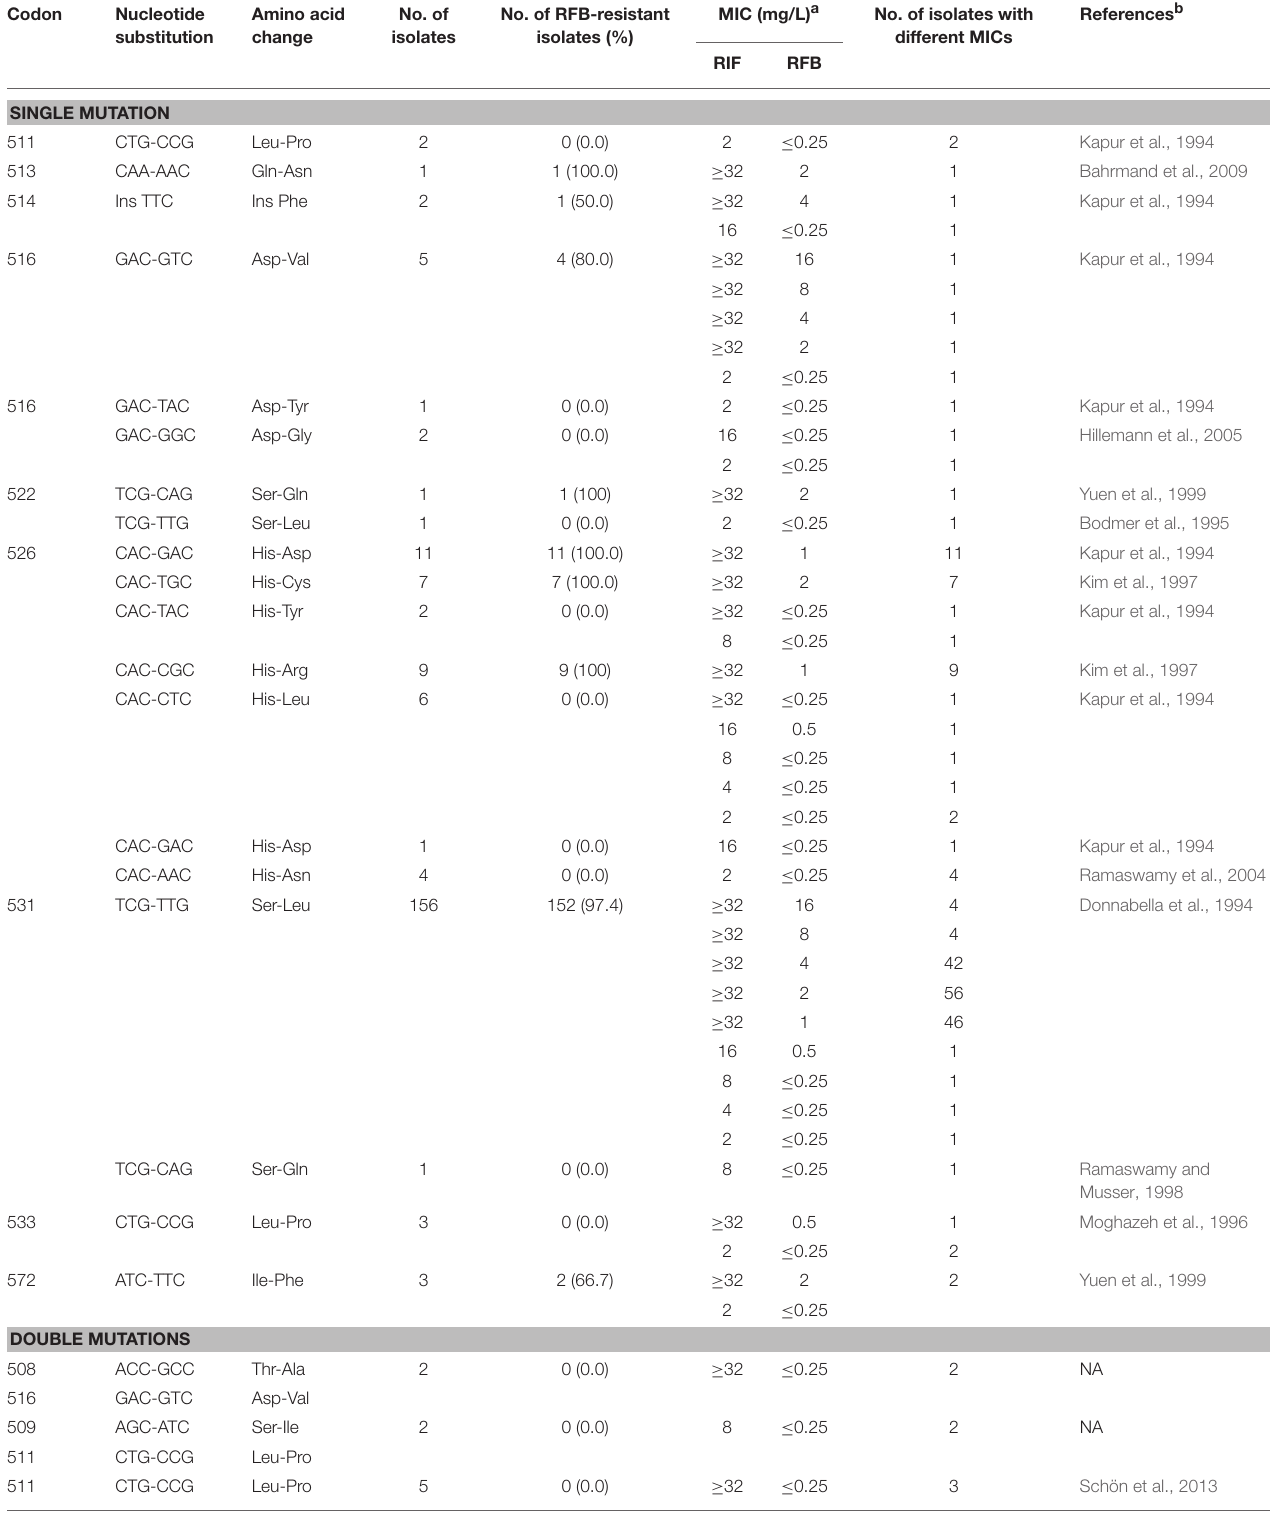
TABLE 1 | Distribution of rpoB mutation and MICs of RIF and RFB.